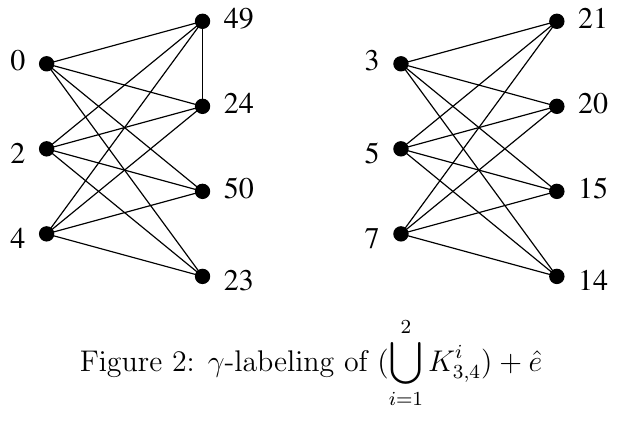
Figure 2: γ -labeling of